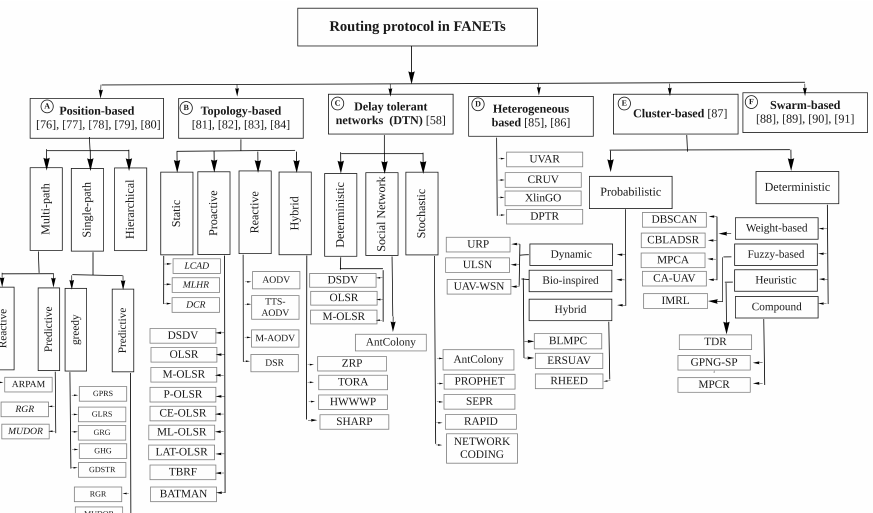
Figure 5. FANET Routing Protocols: position-based, topology-based, DTN, heterogeneous, cluster- based, and